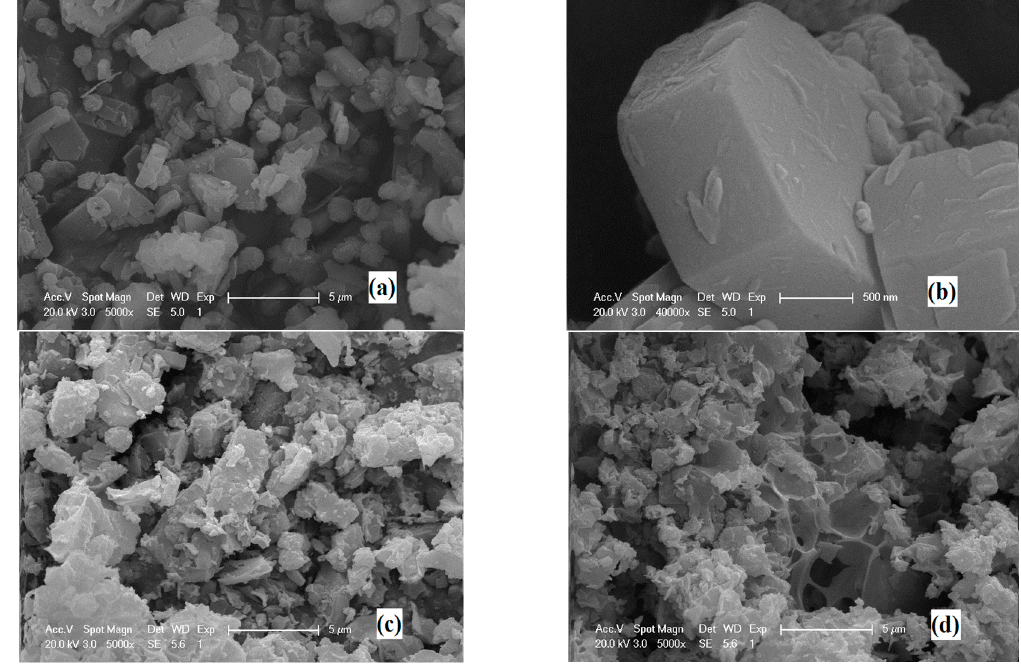
Figure 1. Scanning electron microscopy (SEM) images: ( a , b ) ZSM-5; ( c ) fresh 5Fe5Ce/ZSM-5; ( d ) spent